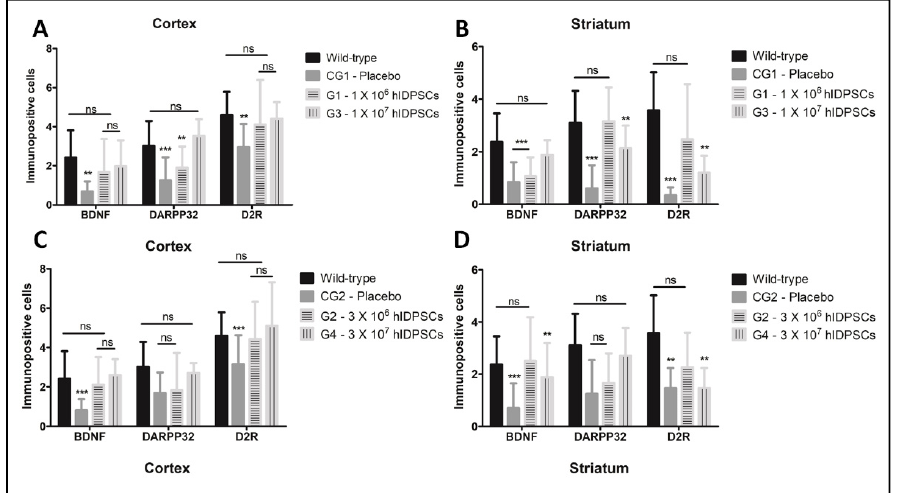
Figure 8. Quantitative analysis showing the number of DARPP32, BDNF and D2R-positive cells in targets regions of striatum and cortex in groups that received a single ( A , B ) or three administrations of hIDPSC ( C , D ). Results show that the intravenous administration of hIDPSCs increased the ex- pression of these three markers in cortex and striatum ( A – D ). In the cortex, results show no statisti- cal difference between the number of BDNF-positive cells in 3-NP rats treated with low and high hIDPSCs ( A , C ). However, it is observed that only the high cell dose increased the number of DARPP32- and D2R-positive cells within the cortex. In turn, only the low dose increases the number of BDNF-, DARPP32- and D2R-positive cells into the striatum ( B , D ). However, results show the absence of statistical differences between the single and triple doses ( p > 0.05). Statistical analysis performed using ANOVA two-way, followed by the Bonferroni’s post hoc test, both with signifi- cance levels of 5%: ** ( p < 0.01), *** ( p < 0.001). p -values > 0.05 indicate the absence of statistical dif- ferences (ns: non-significative).